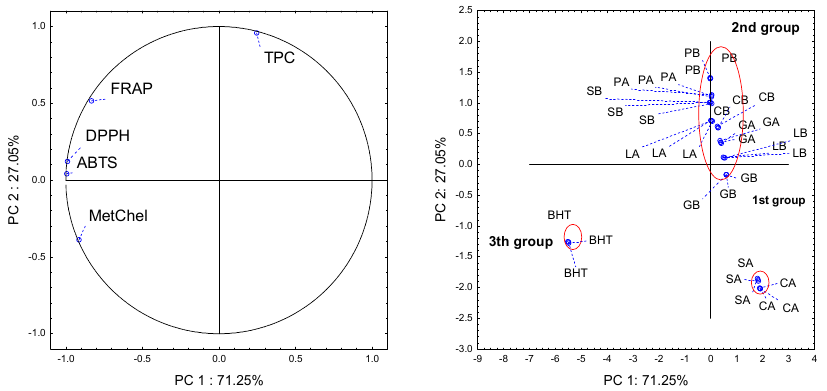
Figure 1. Principal component analysis for loading plot (TPC—total phenolic compounds, DPPH, ABTS, MetChel, and FRAP) and score plot (SA, SB, GA, GB, CA, CB, LA, LB, PA, PB, and BHT).